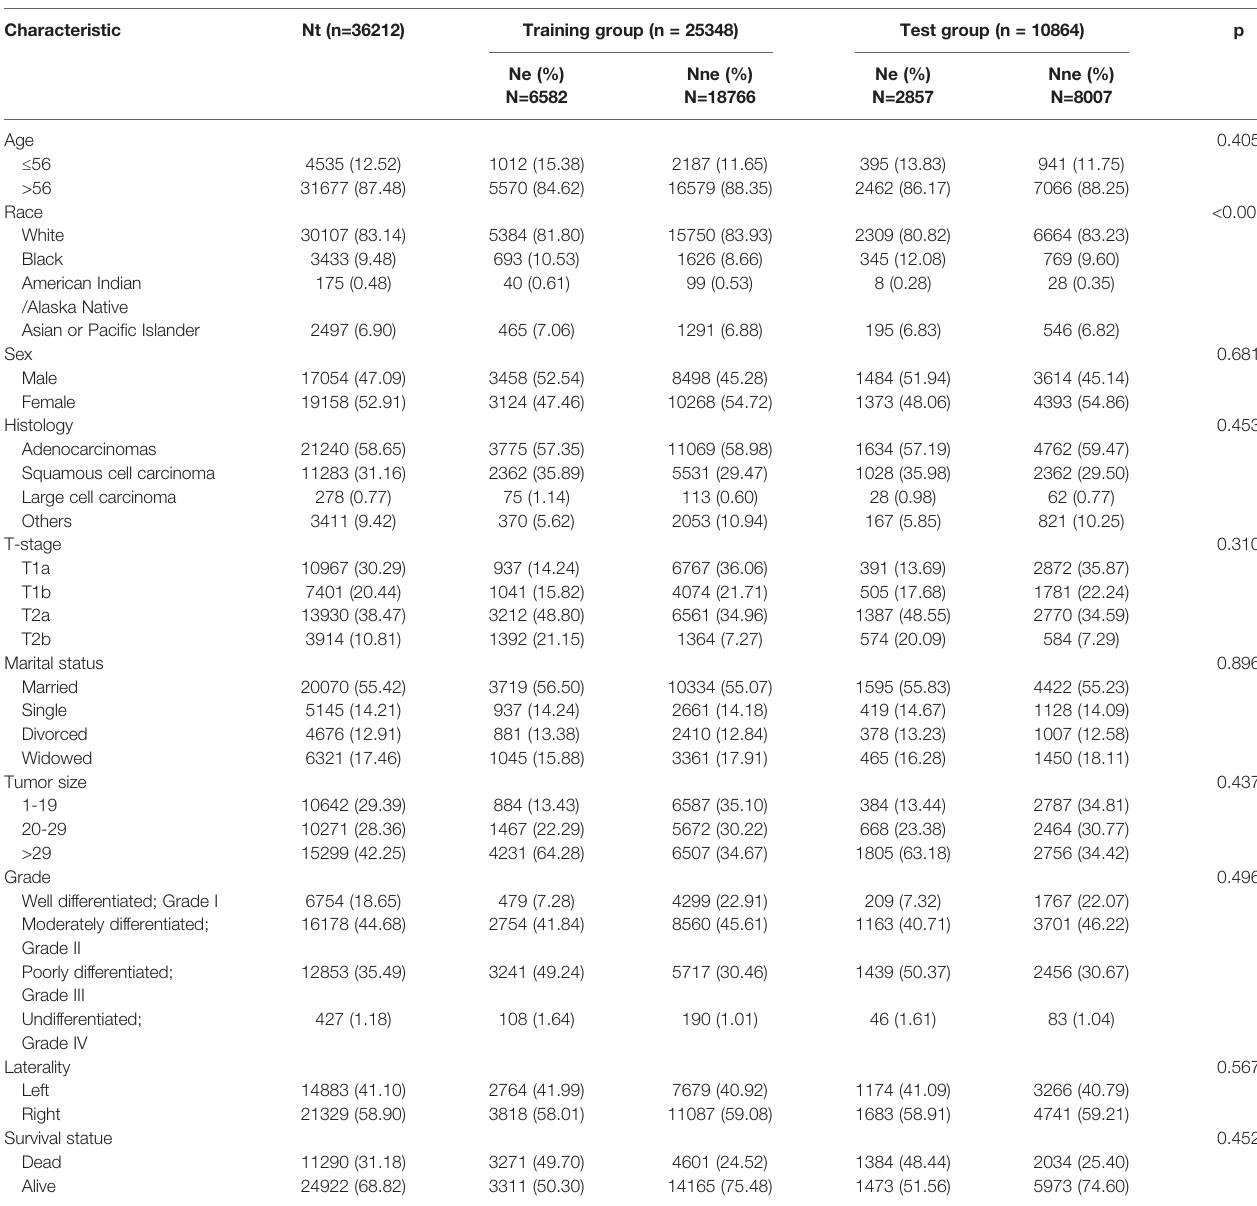
TABLE 1 | Characteristics of patients in cohort N.